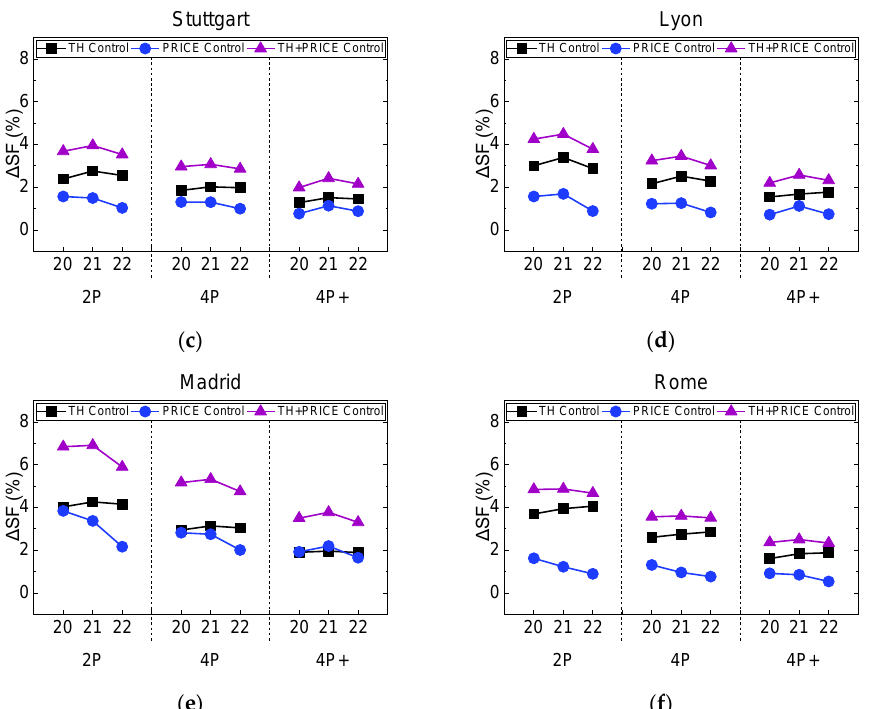
Figure 9. Change in self- sufficiency (ΔSF) due to the advanced control algorithms for the small PV system with battery for the full range of boundary conditions: country, appliance use (2P, 4P, and 4P+) and room set temperature (20, 21, and 22 °C). ( a )–( f ) shows the ΔSF respectively for each of the six examined locations.